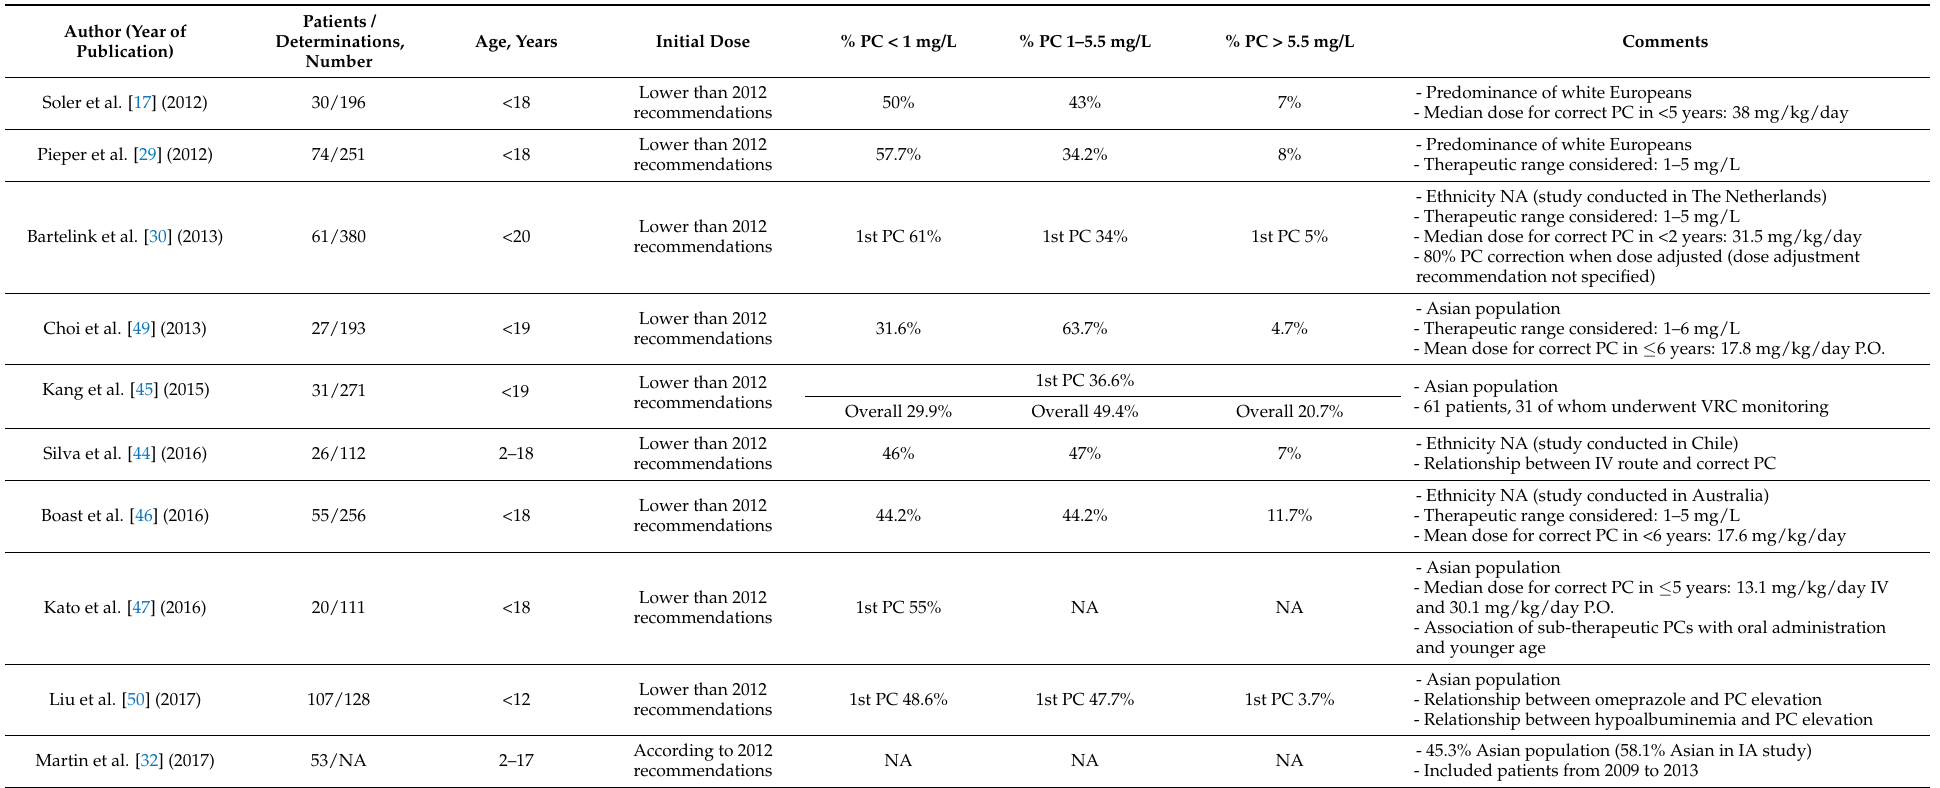
Table 7. Variability of plasma voriconazole levels in recent paediatric